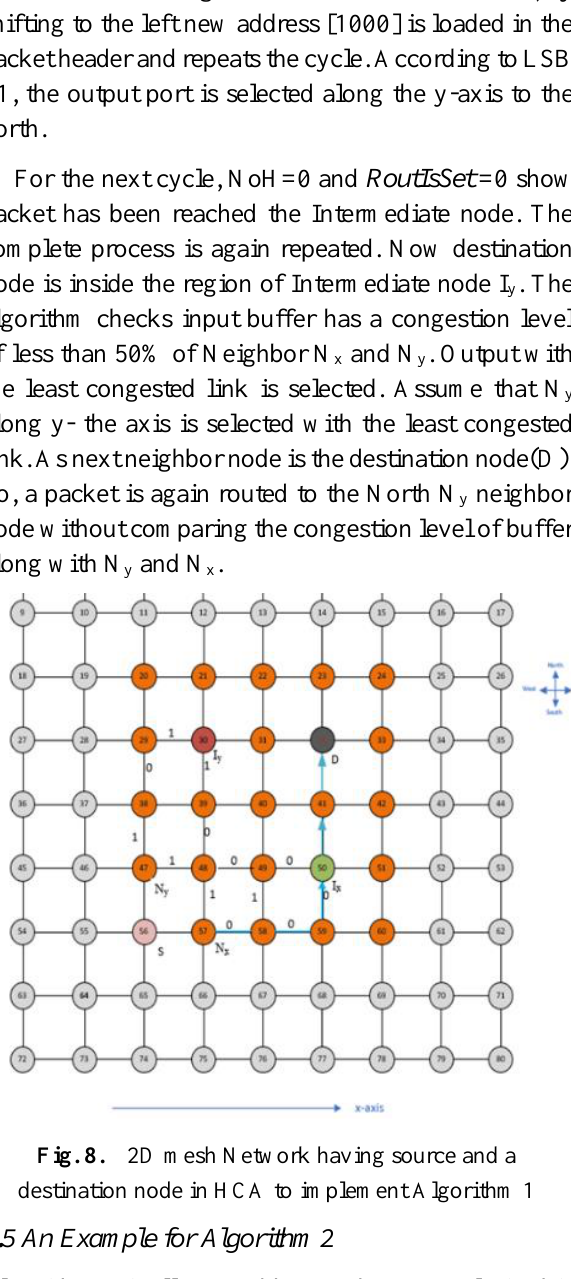
Algorithm 2 checks the closeness centrality of an Intermediate